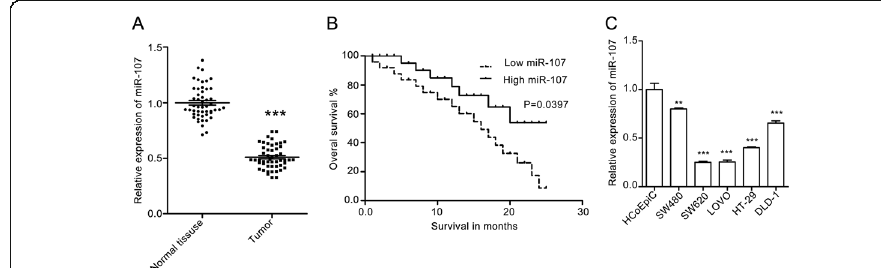
for normalization of the miR-107 levels. Quantitative data are presented as the means ± SEM, n =3. *** p <0.001 compared with the